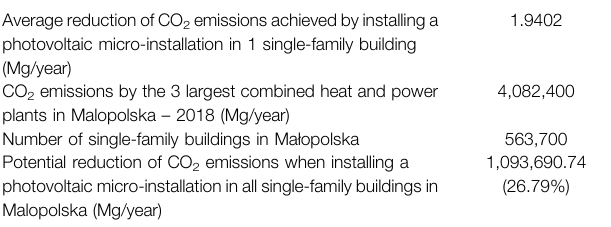
TABLE 9 | Potential reduction of CO 2 emissions when installing a photovoltaic micro-installation in all single-family buildings in Ma ł opolska.